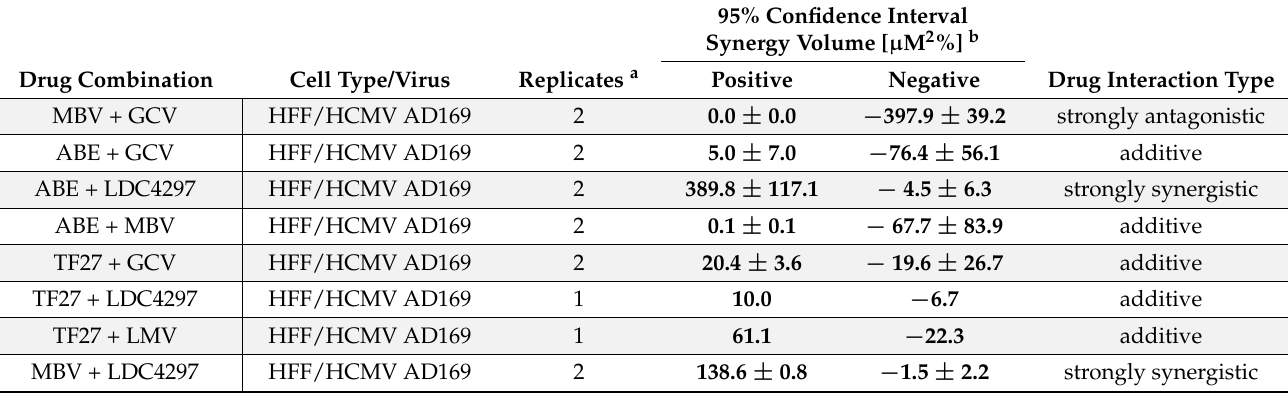
Table 2. Combinatorial anti-CMV drug assessment using the Bliss independence checkerboard